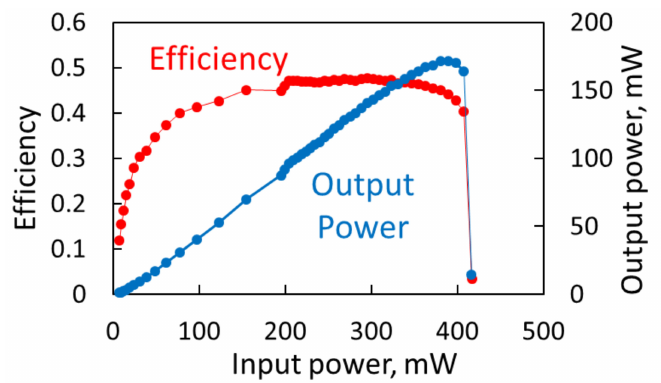
Figure 8. 28 GHz rectifier RF–DC conversion efficiency and DC output power